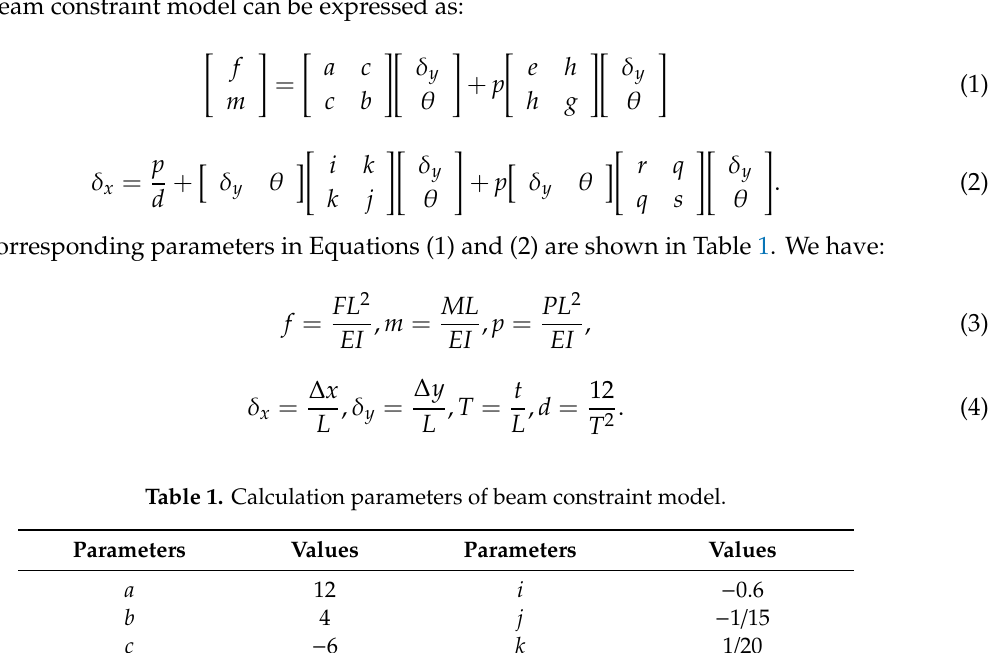
Figure 6. Large deflection of the flexible beam.